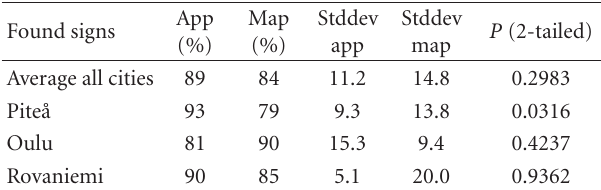
Table 1: Results for finding letter